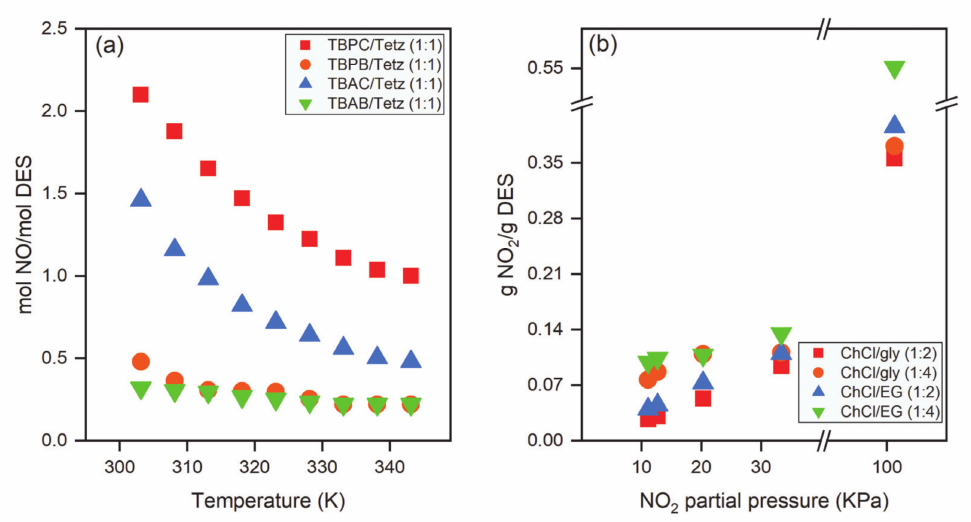
Figure 9. Effect of ( a ) temperature and HBA on the absorption capacity of NO, ( b ) partial pressure on NO2 solubilities in four ChCl-DESs at 298.15 K